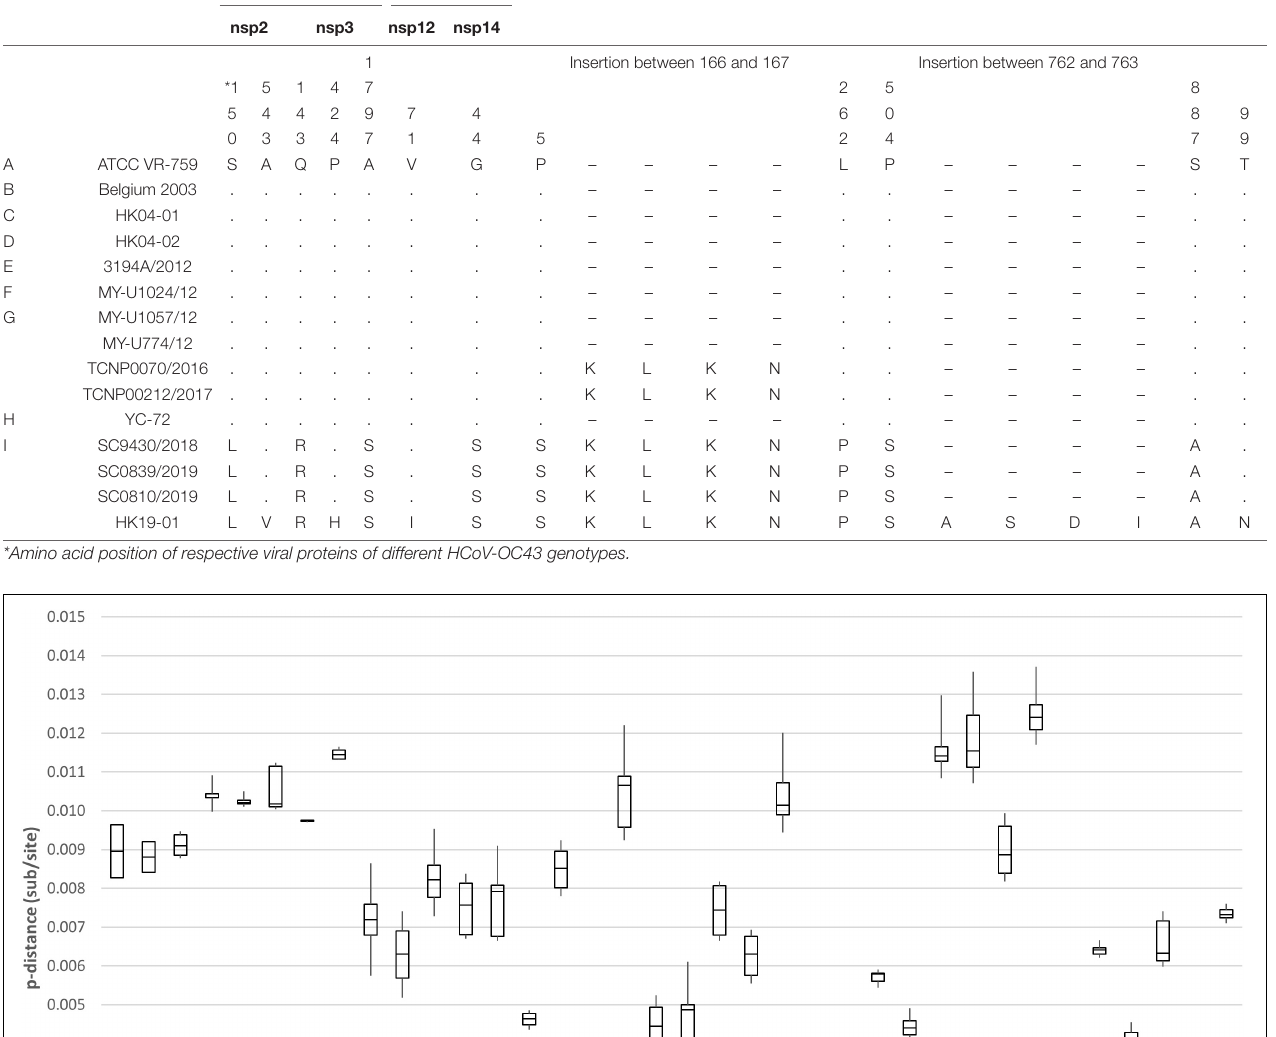
TABLE 2 | Signature amino acid substitutions of the novel HCoV-OC43 genotype. Genotype Strain